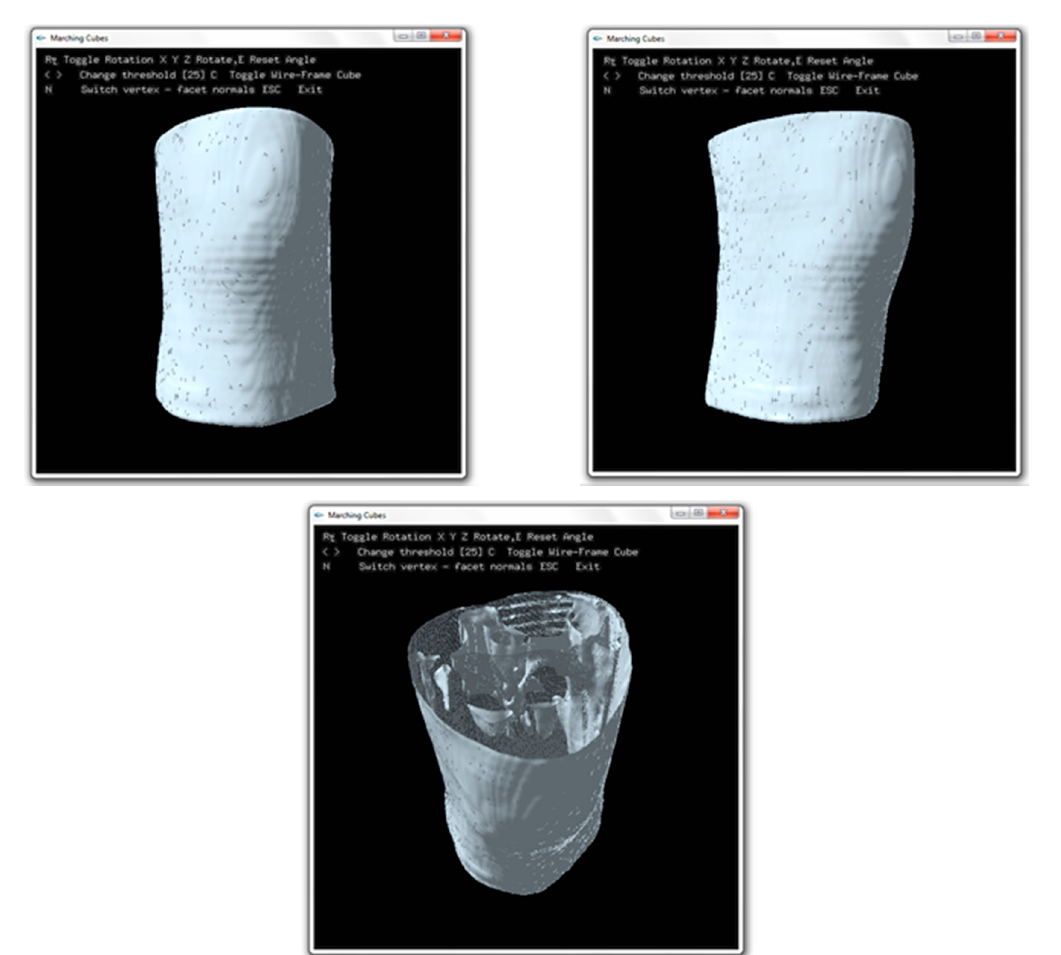
Figure 12. The screen captured of 3D medical visualization program.